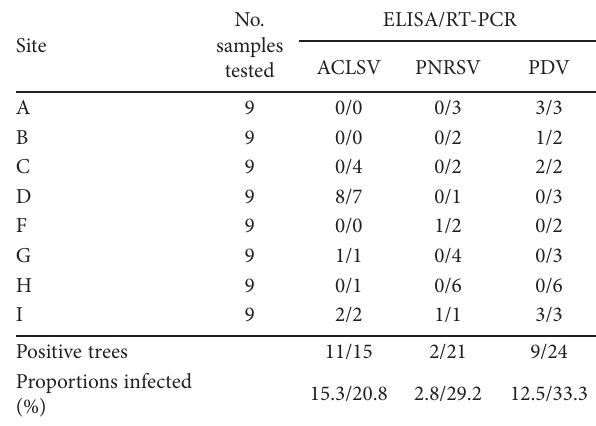
Table 3. Comparison of results (based on 72 samples) obtained by ELISA and RT-PCR techniques for cherry tree samples collected during spring 2018, presented per orchard and virus. For both ELI- SA and RT-PCR, petals were used to determine apple chlorotic leaf spot virus (ACLSV), Prunus necrotic ringspot virus (PNRSV), and prune dwarf virus